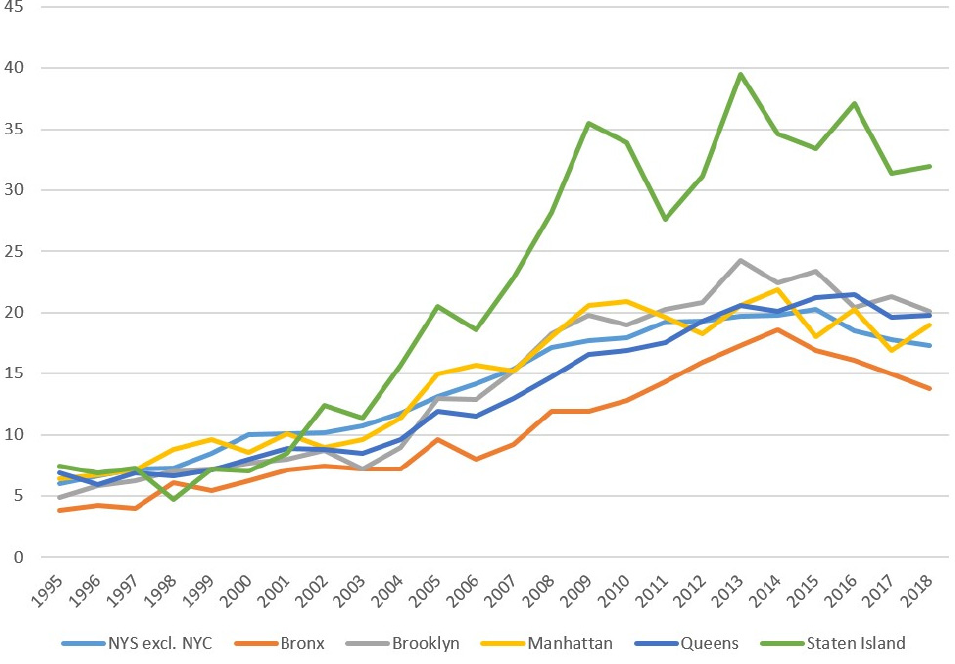
Figure 1. Age-adjusted thyroid cancer incidence rates for the NYC boroughs and NYS excluding NYC (1995–2018). NYC